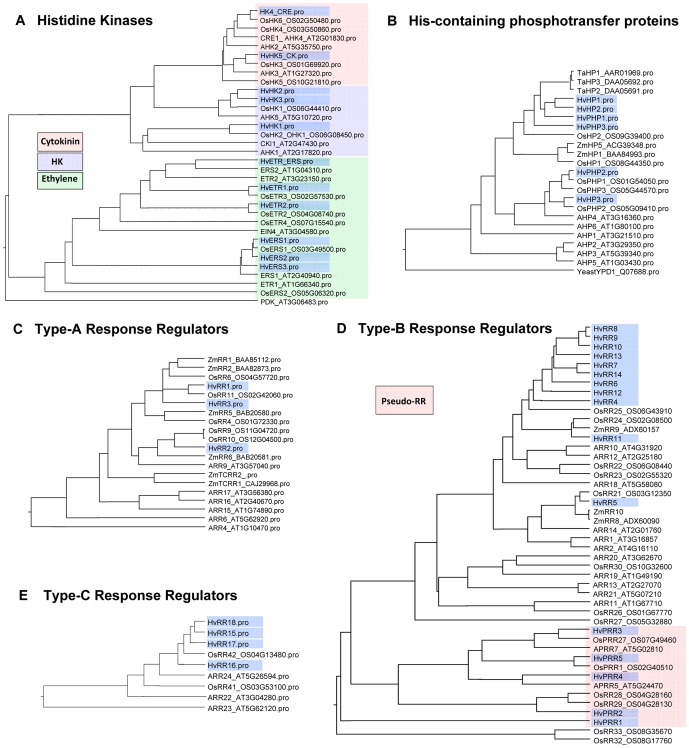
Phylogenetic relationship of barley TCS elements and counterparts of Arabidopsis thaliana and Oryza sativa.Phylogenetic trees are based on inferred amino acid sequences from complemented barley 454 contigs (see information in Table 2) and full-length amino acid sequences adopted from different databases (TAIR release 9, Rice Genome Annotation project and NCBI Protein database). Multiple alignments were performed using ClustalW algorithm with BLOSUM protein weight matrix (DNAstar software). Barley sequences are highlighted by blue boxes. Elements from other species are identified by chromosome loci or GenBank accession number. (A) Histidine kinases, colours indicate different subgroups. Arabidopsis PDK was used as outgroup. (B) HPt elements, protein sequences of Zea mays and Triticum aestivum were additionally included in the alignment. Yeast HPt protein YPD1 was used as outgroup. (C–E) Type-A, -B, -C response regulators, amino acid sequences of selected maize response regulators were included in the alignment. For reasons of simplicity not all Arabidopsis and rice elements were included in the phylogenetic trees.